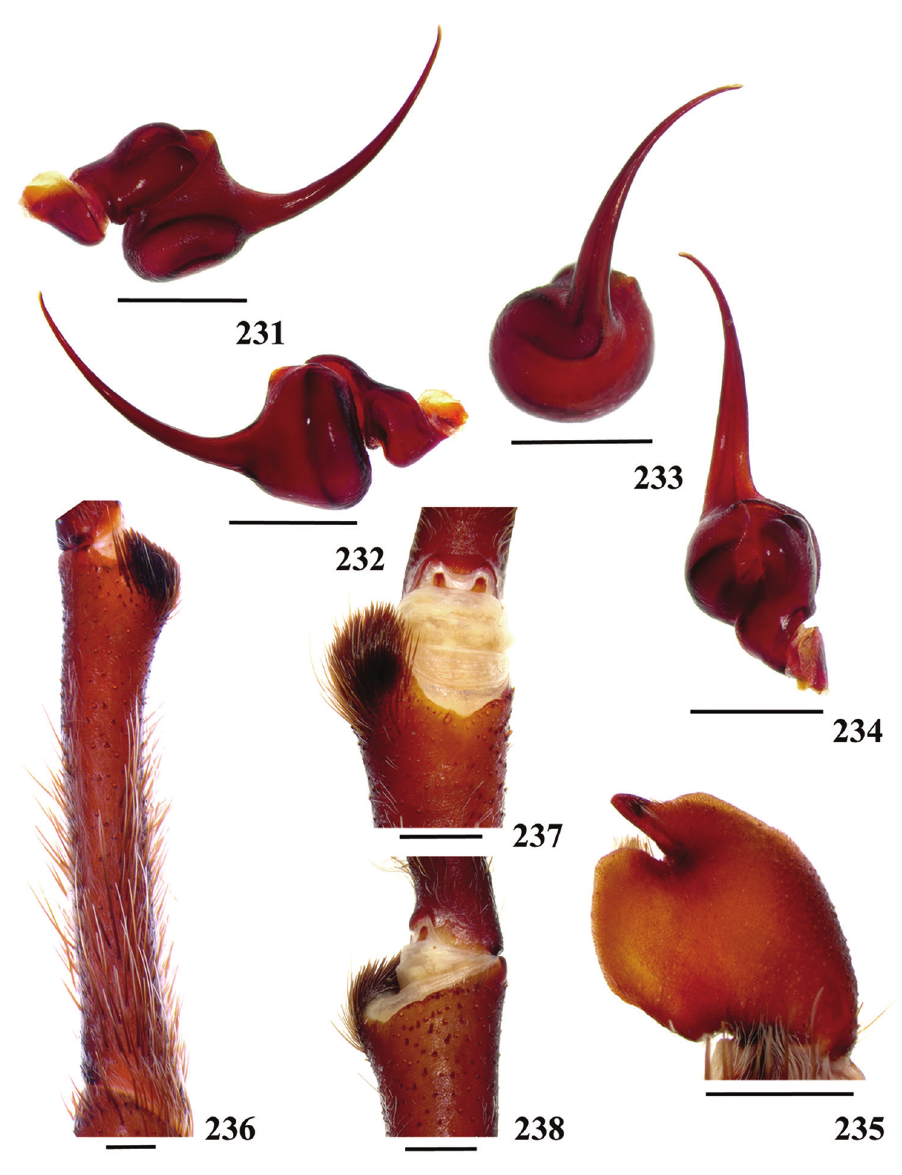
Figures 231–238. Caribena laeta (C. L. Koch, 1842) comb. n., male (AMNH PR). 231–234 left palpal bulb 231 prolateral 232 retrolateral 233 frontal 234 dorsal 235 left cymbium, dorsal 236–238 left tibial apophysis of leg I 236 prolateral 237 ventral 238 retrolateral. Scale bars = 1 mm. Fovea: deep, straight, 2.06 wide. Eyes: eye tubercle 1.07 high, 2.43 long, 3.51 wide. Clypeus 0.20. Anterior row of eyes procurve, posterior row slightly recurve. Eye size and interdistances: AME